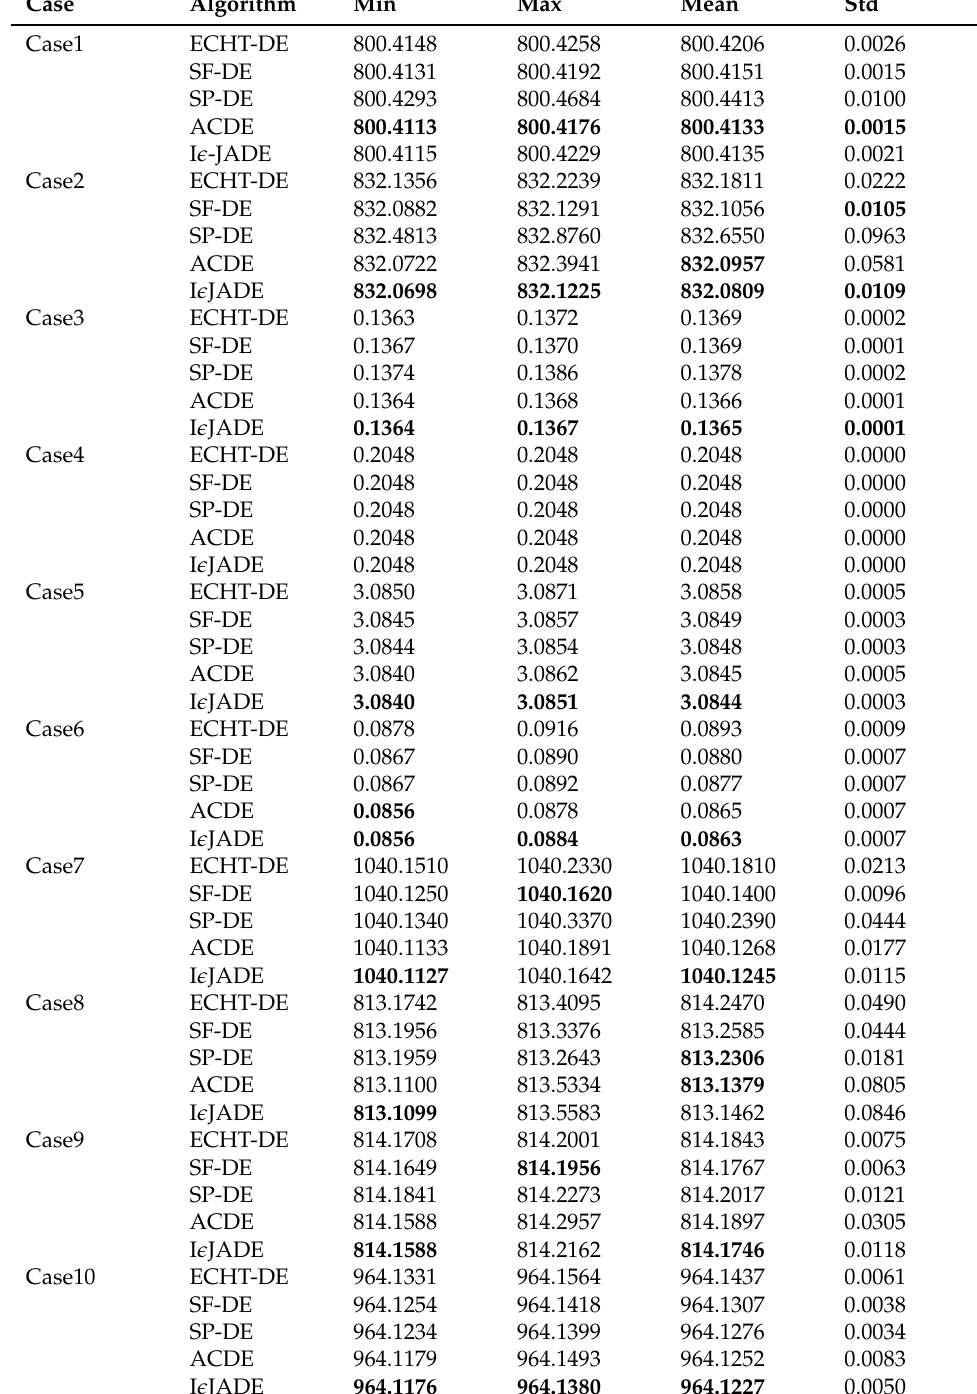
Table 2. Experimental results of the I (cid:101) JADE and the state-of-the-art